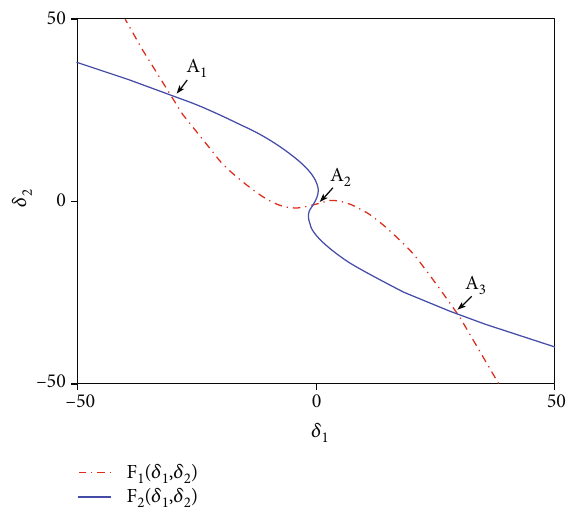
Figure 8: Function curves of (4) and (5) as well as the intersection points when k = 0 : 5 . The red curve corresponds to function (4), and the blue one is for function (5). A intersection